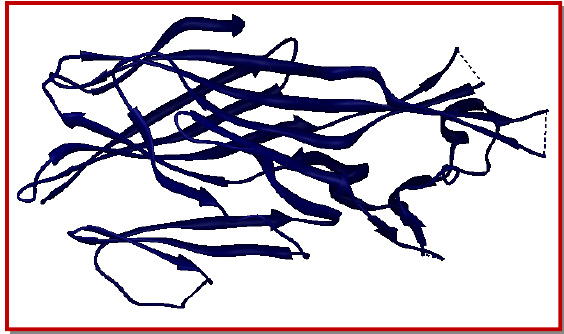
Figure 1: 3D-structure of 2QK7.A.pdb of gamma-hemolysin component A of Staphylococcus aureus subsp. aureus MW2 ren- dered in UCSFChimera software